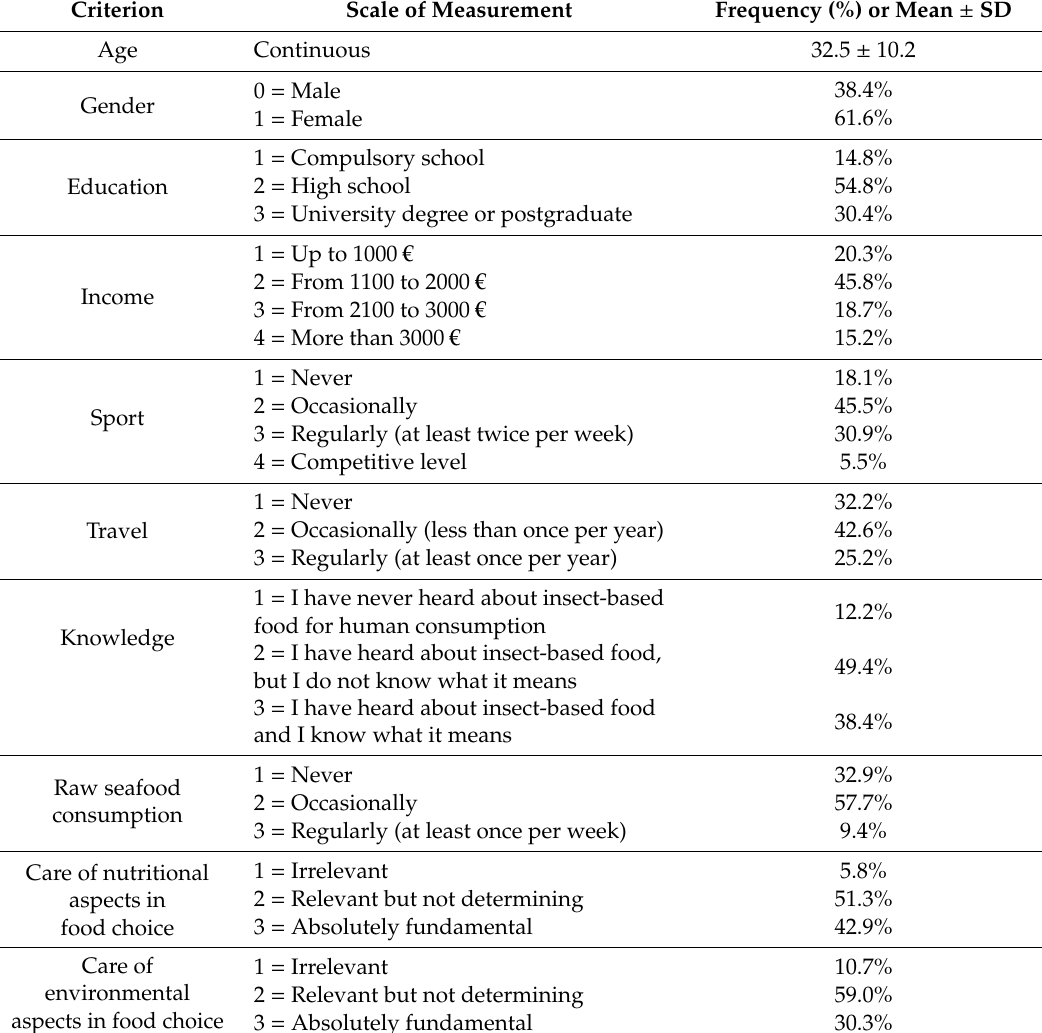
Table 2. Sample statistics on socio-demographic information and consumers’